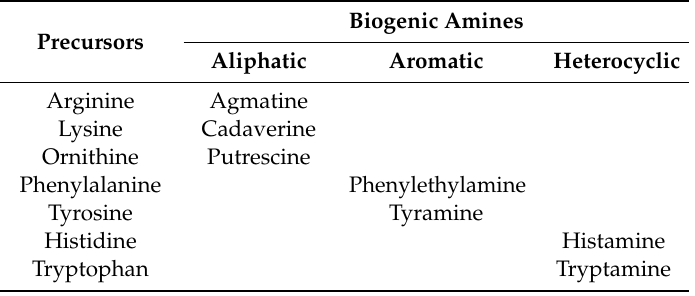
Table 1. Classification of biogenic amines based on chemical